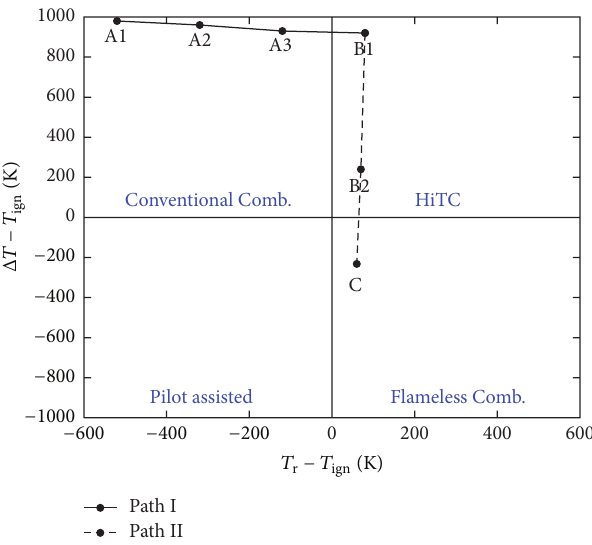
Figure2:Locationofallcasesinacombustionmodechartproposed by [8,